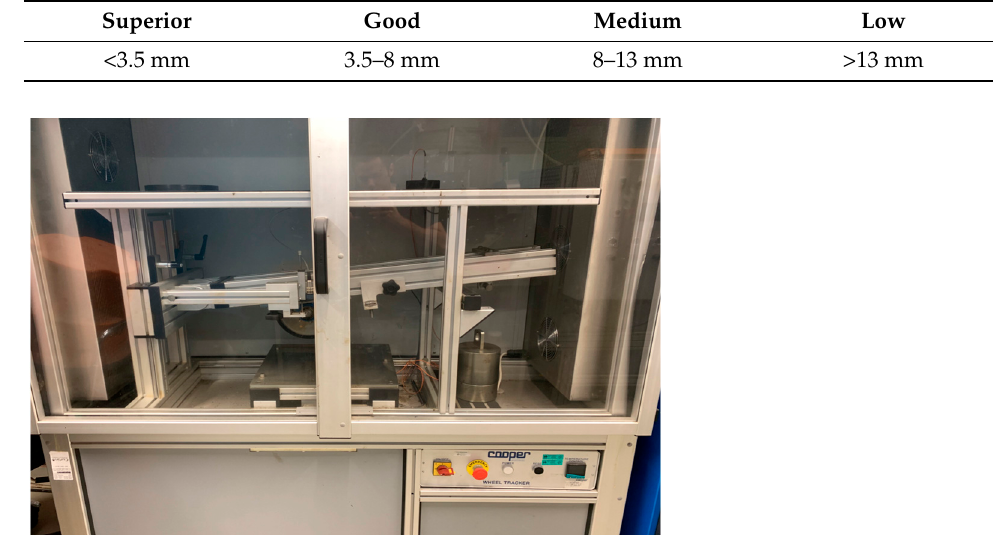
Figure 4. Cooper wheel tracker device. Table 5. Mixed performance criteria